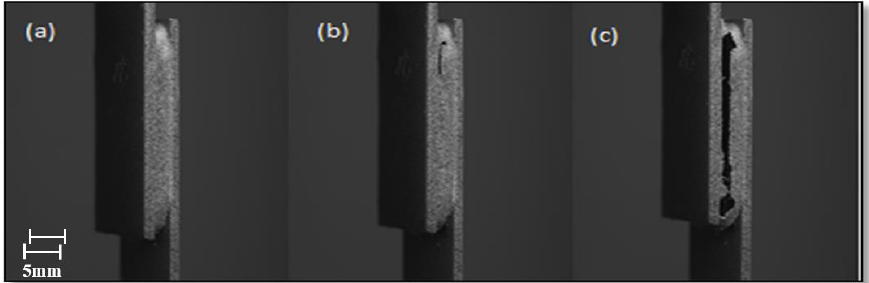
Figure 8. Image of 2 mm polydimethylsiloxane (PDMS) thickness: ( a ) before deformation; ( b ) beginning of rupture; ( c ) after rupture.